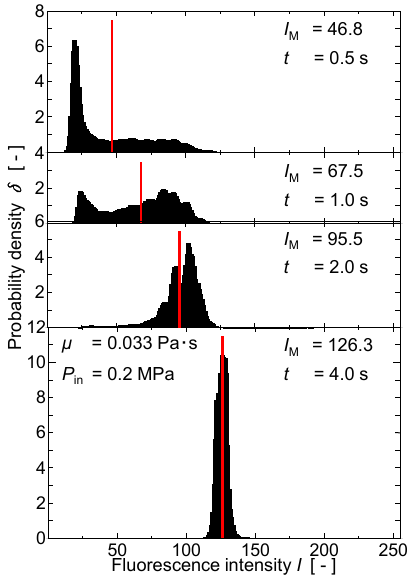
Figure 12. Fluorescence intensity distribution.